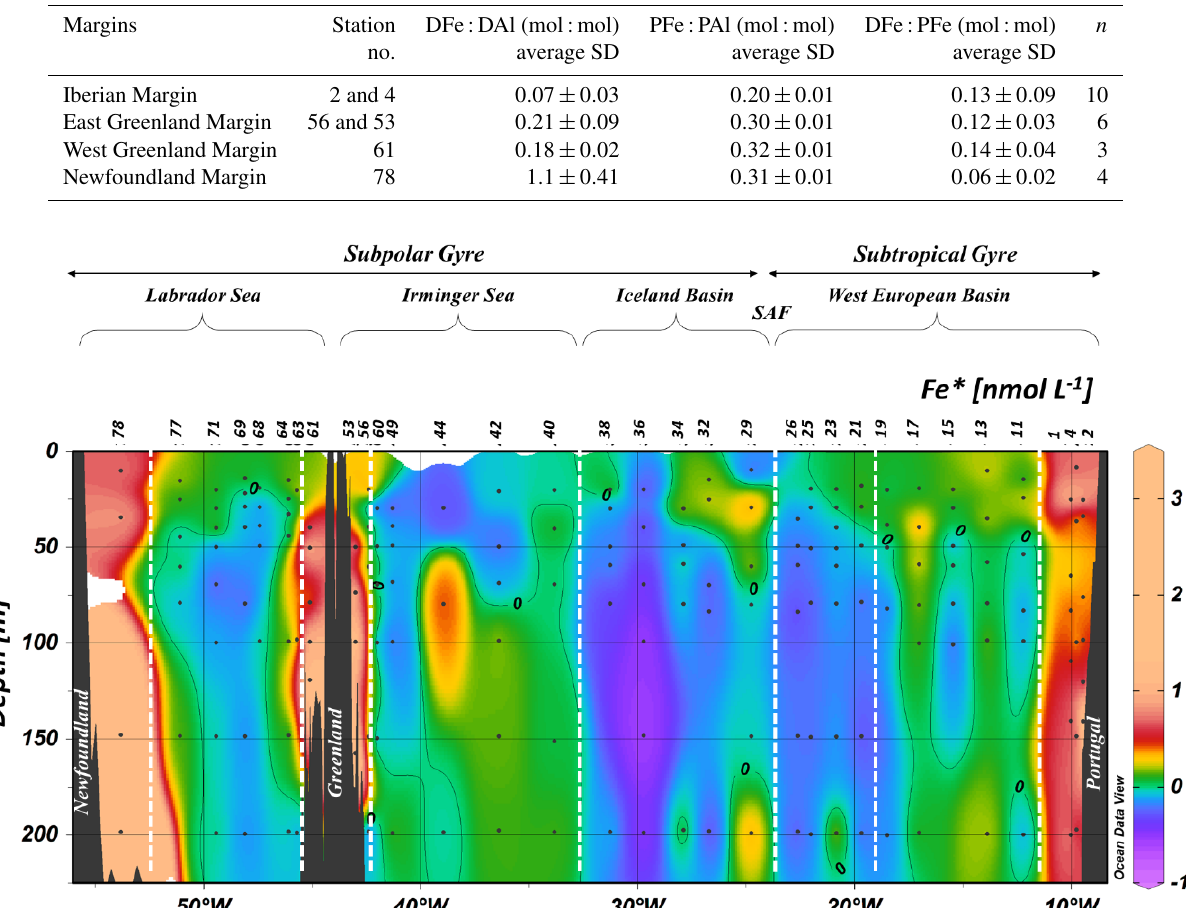
Table 3. Averaged DFe:DAl (Menzel Barraqueta et al., 2018) and PFe:PAl (Gourain et al., 2020) ratios reported per margin. Note that to avoid phytoplankton uptake, only depths below 100m depth are considered.